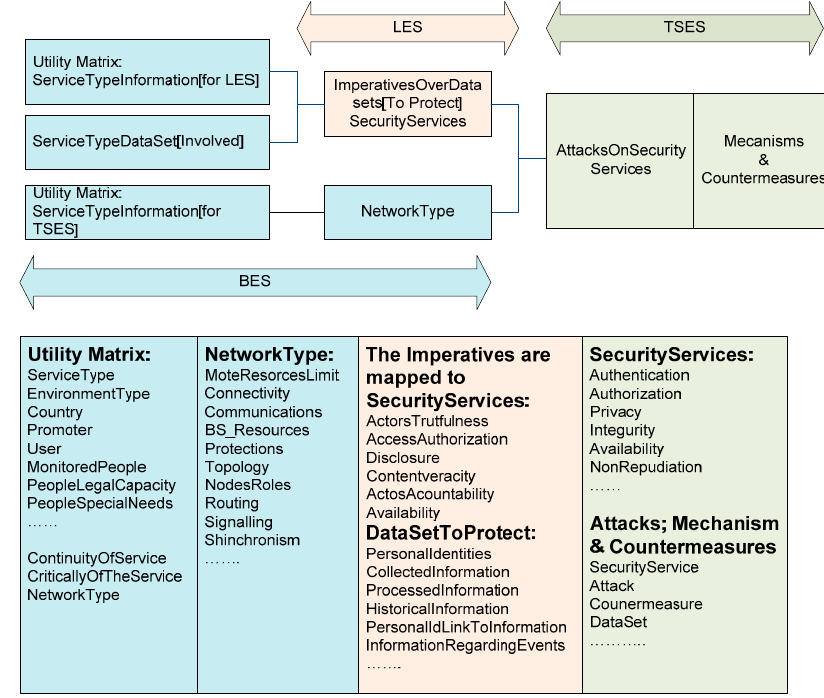
Figure 11. Overview of the system